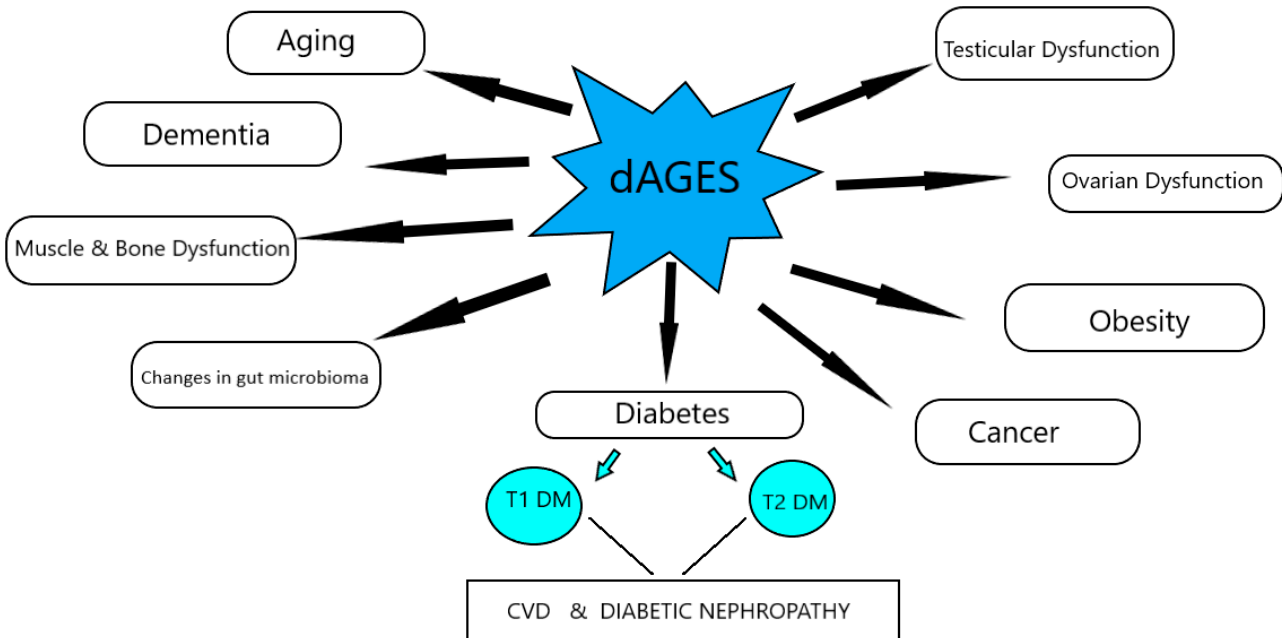
Figure 1. Effects of dAGEs on health and disease, according to animal studies.